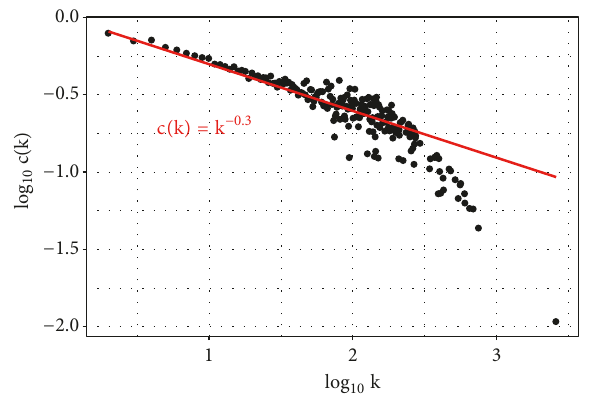
Figure12:Localclusteringcoefficientasafunctionofthe 𝑘 [1,𝑖𝑛] 𝑗 node